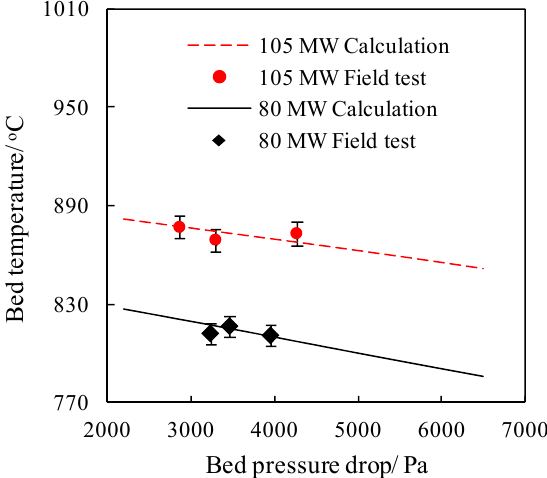
Figure 4. E ff ect of bed pressure drop on the carbon content. Figure 4. Effect of bed pressure drop on the carbon content.